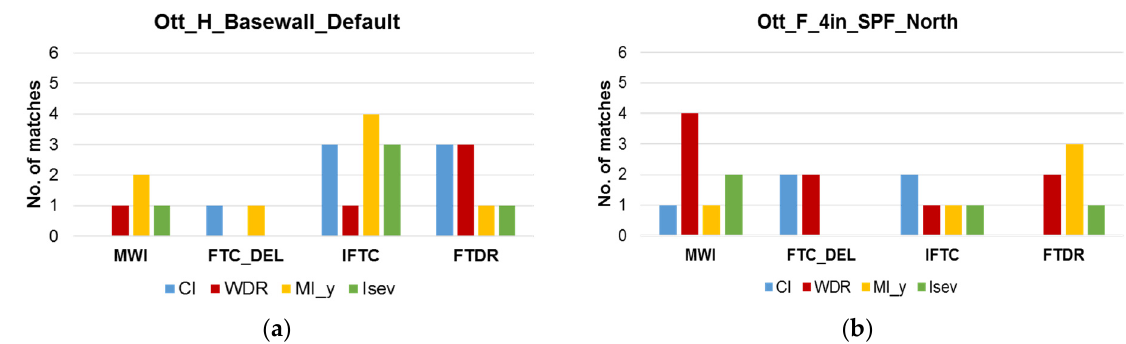
Figure 4. Number of matching years between climate-based indices ( x -axis) and the response-based indices (legend) for ( a ) a base wall facing prevailing WDR orientation under historical climate, and ( b ) a retrofit wall facing North under future climate, in Ottawa.